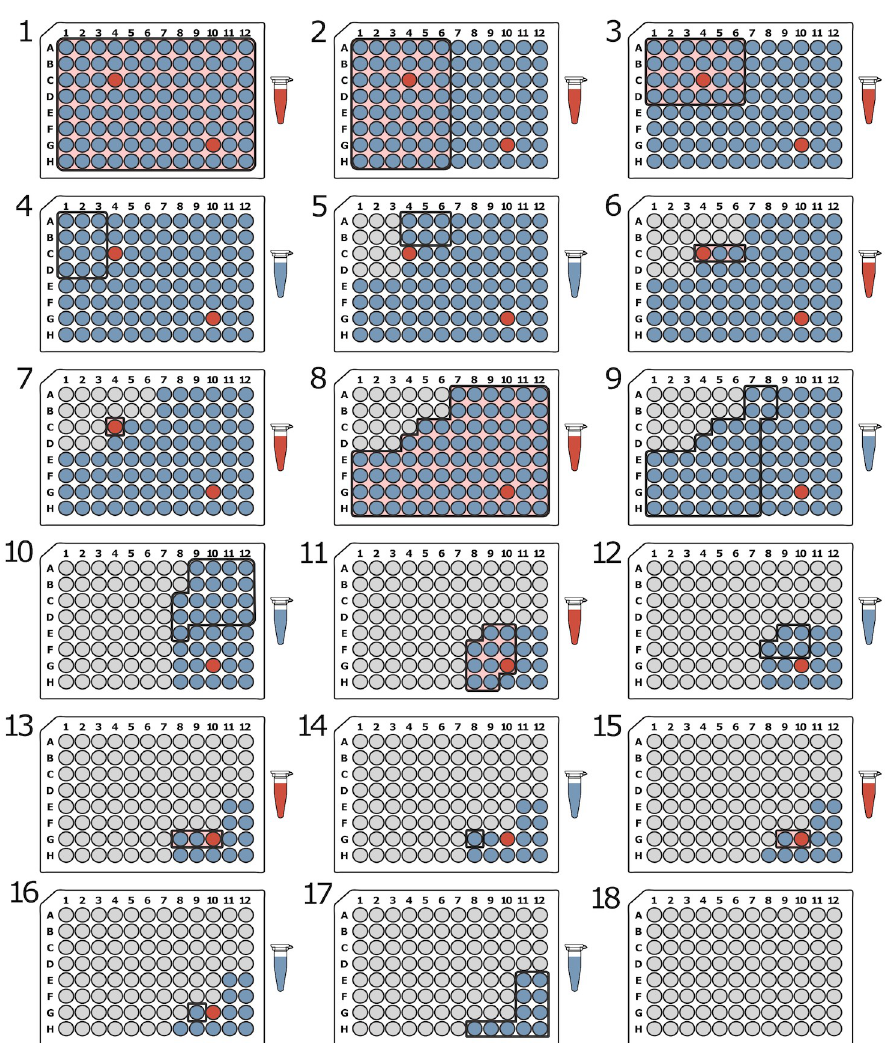
Fig 4. Binary splitting by halving pooling example. In this example, there are N = 96 samples and two of the samples are positive (red wells). To begin, all of the samples are pooled and tested (Step 1). If the first test is negative, testing is complete and all samples are considered negative. Otherwise, half of the samples are pooled and tested (Step 2). If the tested half is negative, then all of the samples in the tested half are considered to be negative and at least one positive sample is known to be present in the other non-tested half of the samples. If the tested half is positive, then it contains at least one positive sample and no information is gained about the other untested half. In either case, the method continues by halving and testing whichever group is known to contain a positive sample until a single positive sample is identified (either by individual testing, as seen in Step 7, or by elimination, as seen in Step 16). Once a single positive sample is identified, the remaining unresolved samples (non-grey wells) are pooled and tested to determine if any positive samples remain and the process continues until all positive samples are identified. Only one test is required per round, and in this example, it takes 17 sequential rounds to recover both positive